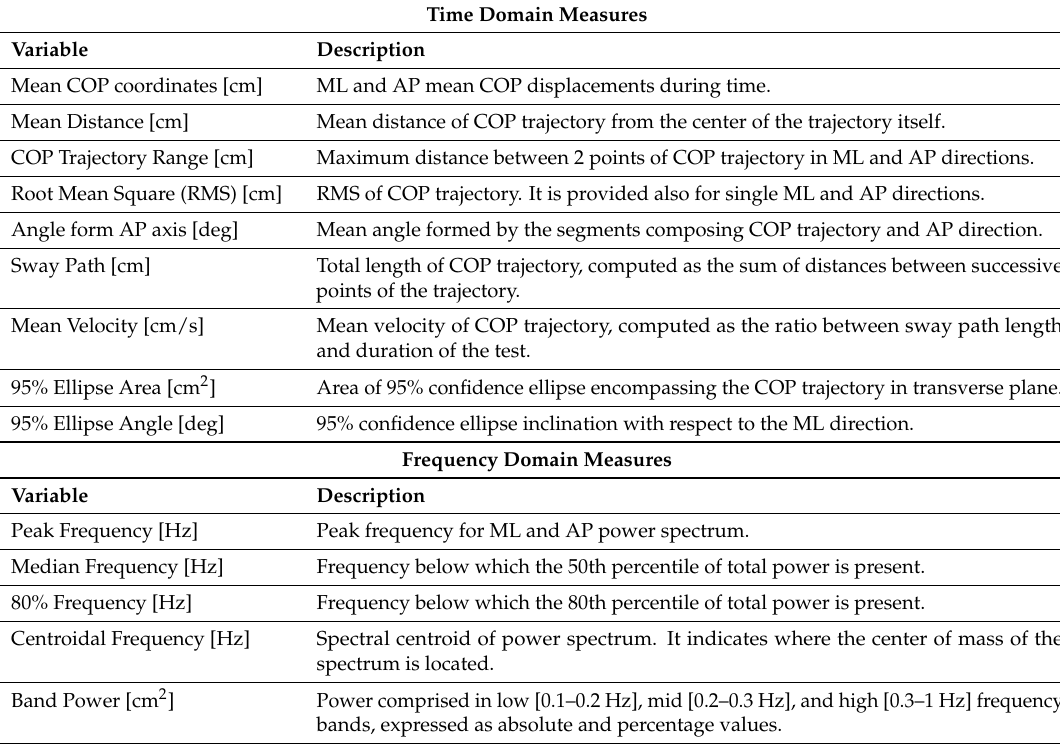
Table 2. Static postural assessment